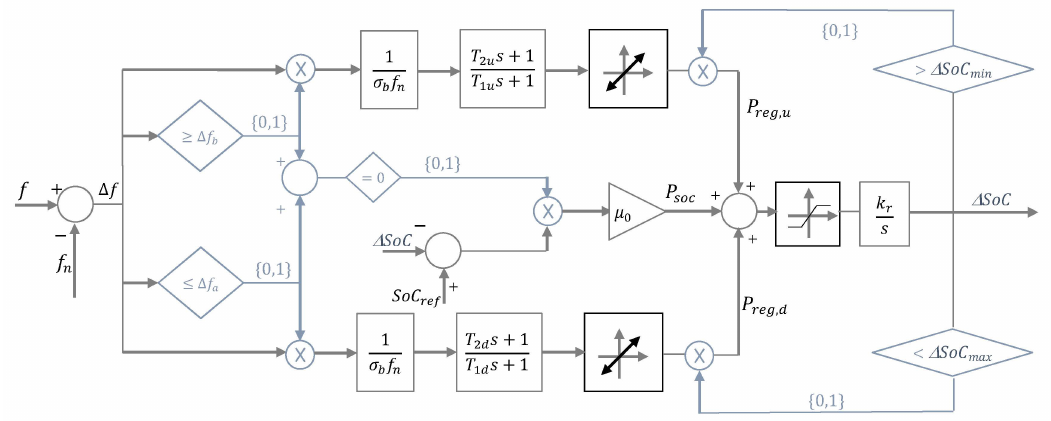
Figure 3. Block diagram of the BESS control strategy for primary frequency regulation.